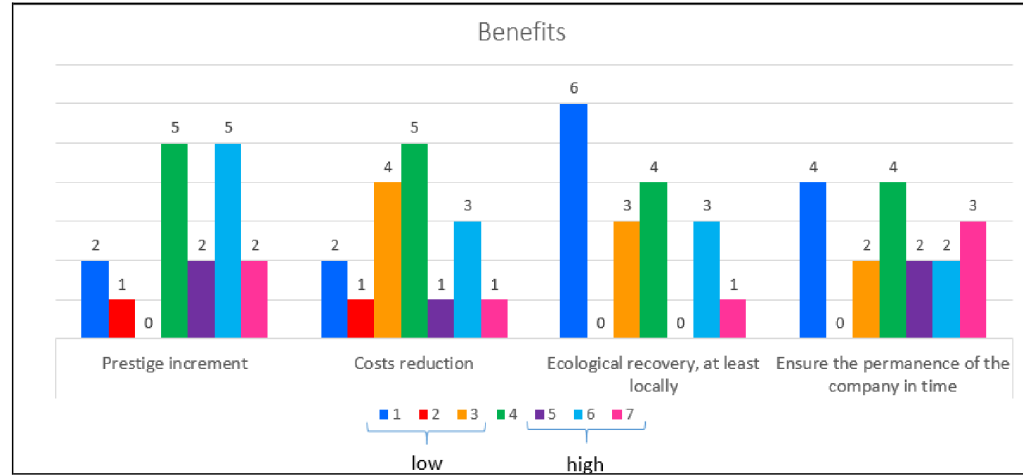
Figure 5. Benefits of implementing Circular